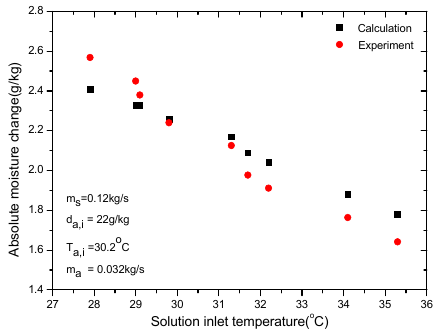
Figure 6. Influence of solution temperature on dehumidification